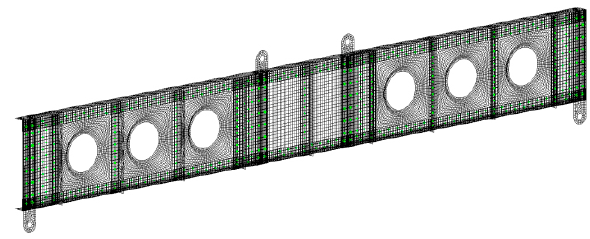
Fig. 5. Finite element model